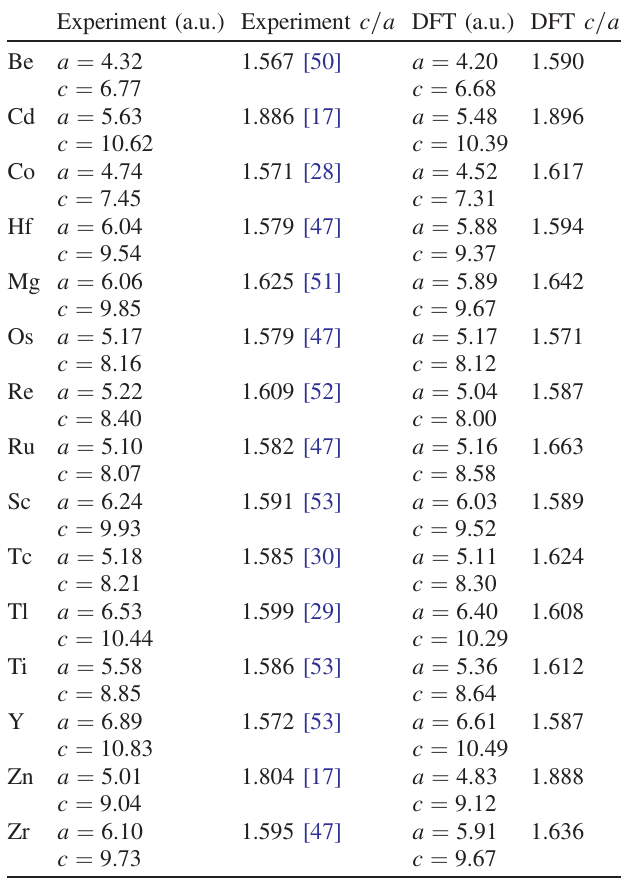
TABLE I. Calculated lattice constants of the 15 hcp metals compared with the experimental literature